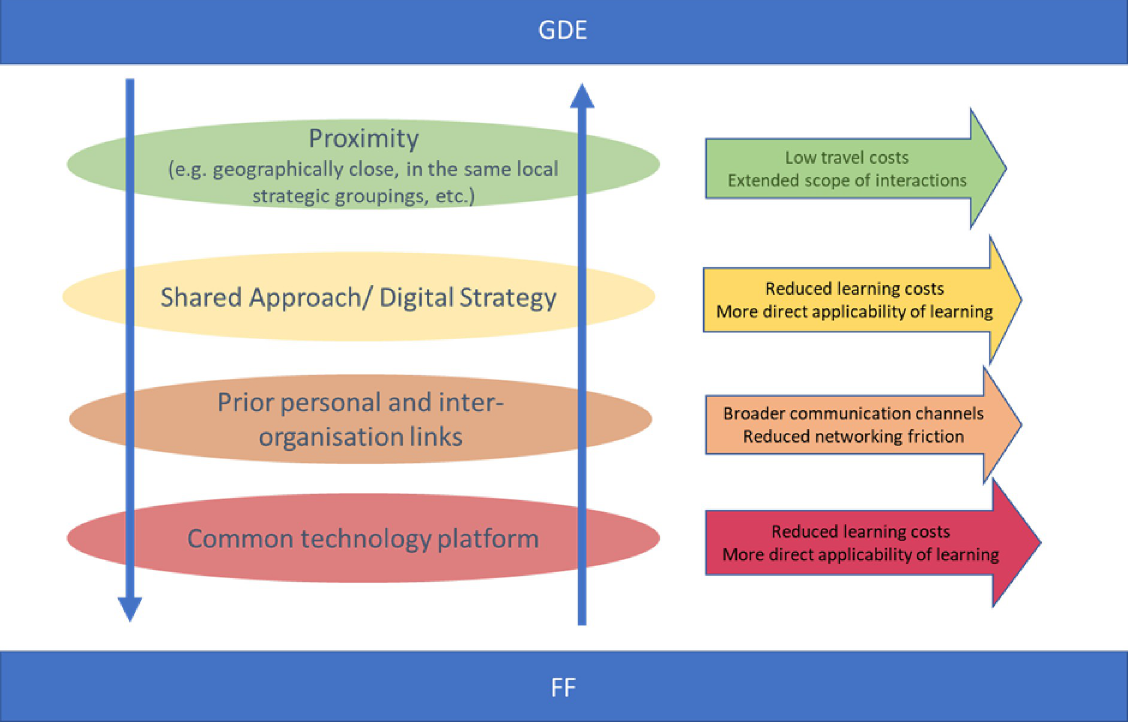
Fig 2. Factors promoting informal networking between Global Digital Exemplar and Fast Follower